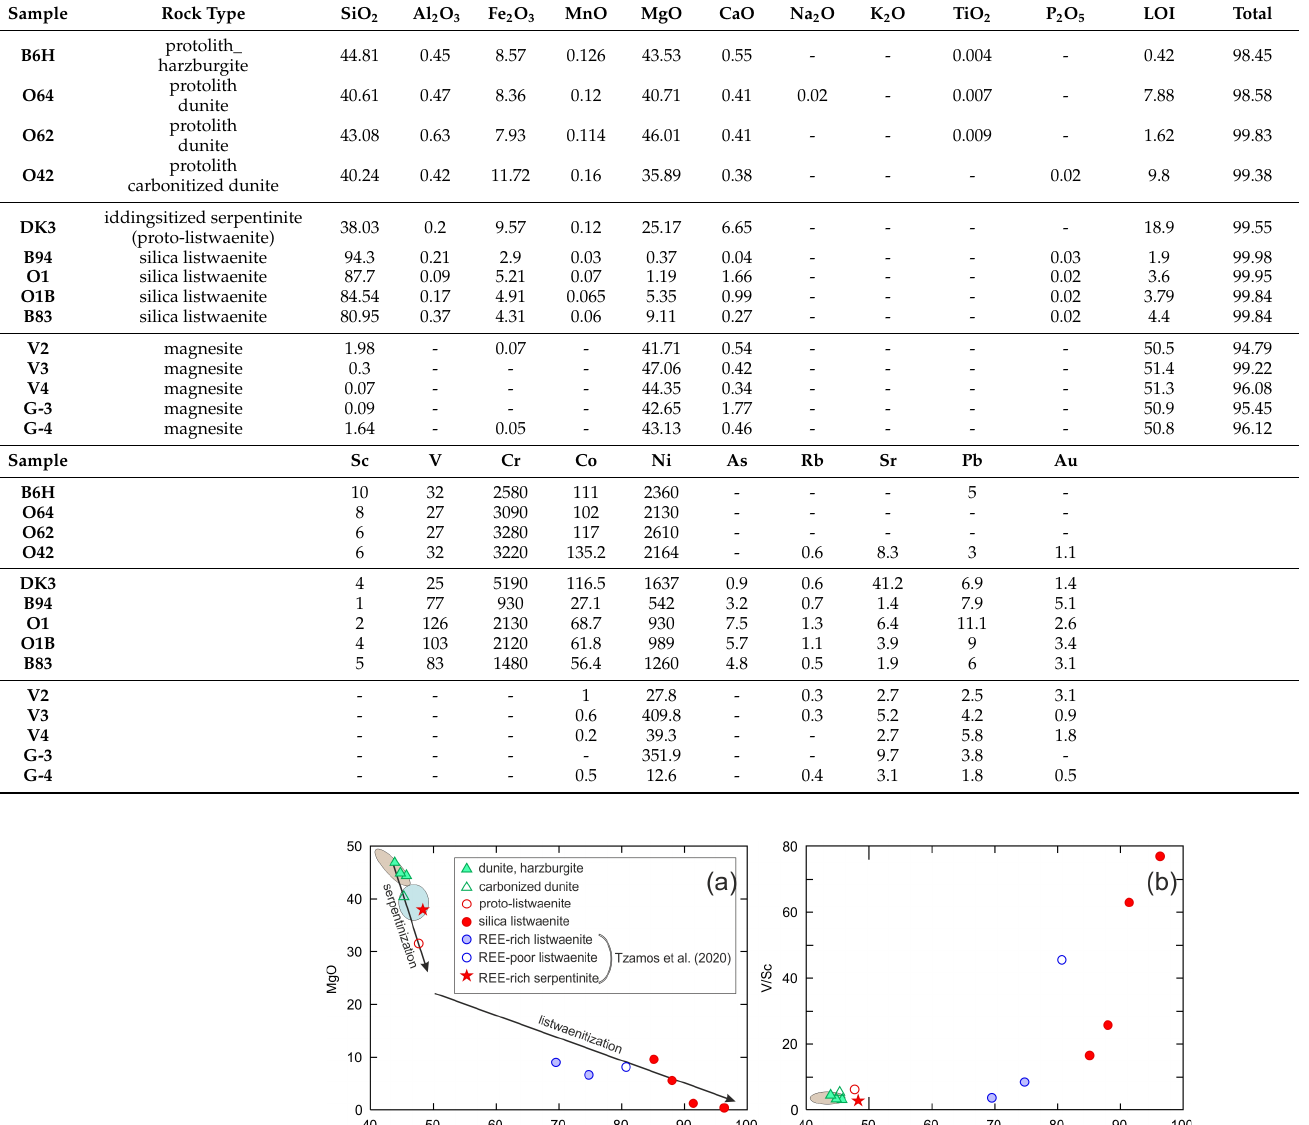
Table 1. Major (wt%) and trace (ppm, Au in ppb) element concentrations of the studied protoliths, proto-listwaenite, silica listwaenites and magnesites from the Vavdos and Gerakini-Ormylia mantle section; “-”: bellow detection.